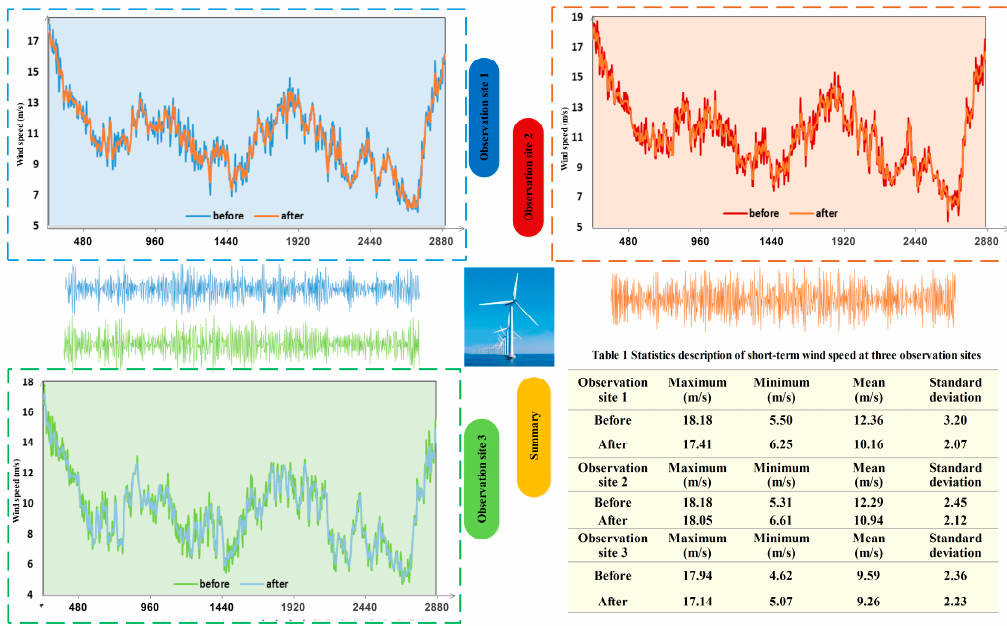
Figure 2. The denoising process of original time series data.